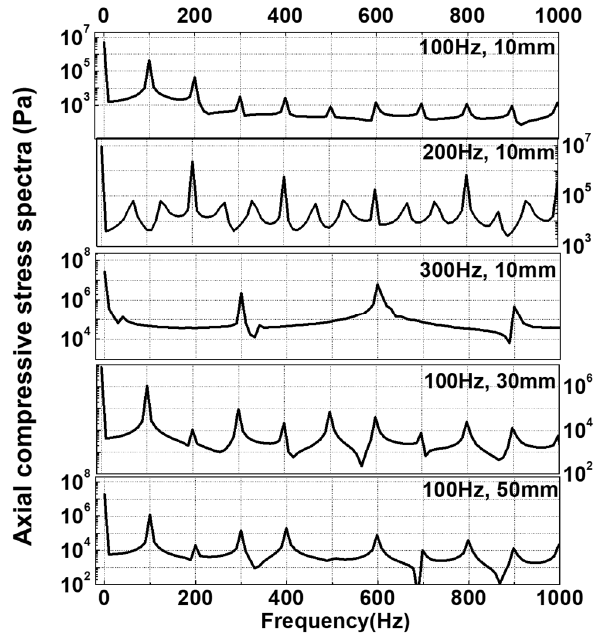
Figure 12. Spectra of axial compressive stress signals on the stress concentration node of the press- board in phase 3 under different vibration conditions.